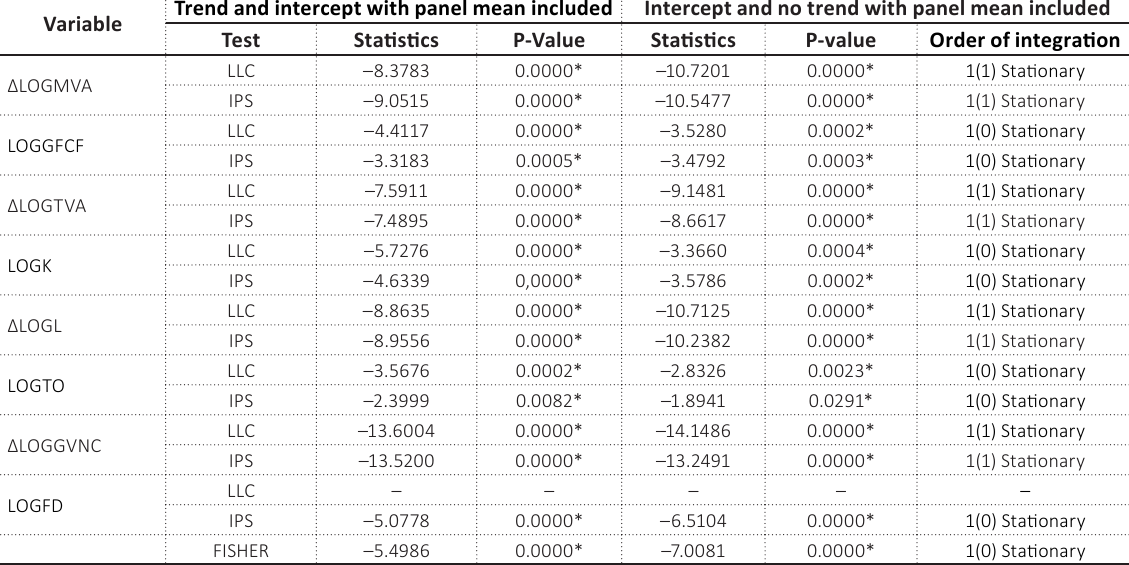
Table 1. Stationarity results of the LLC and IPS tests for key variables of the technical efficiency